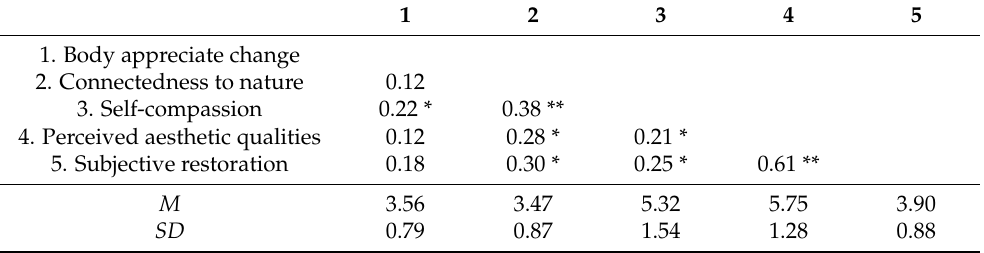
Table 1. Descriptive statistics and Pearson’s correlation coefficients.